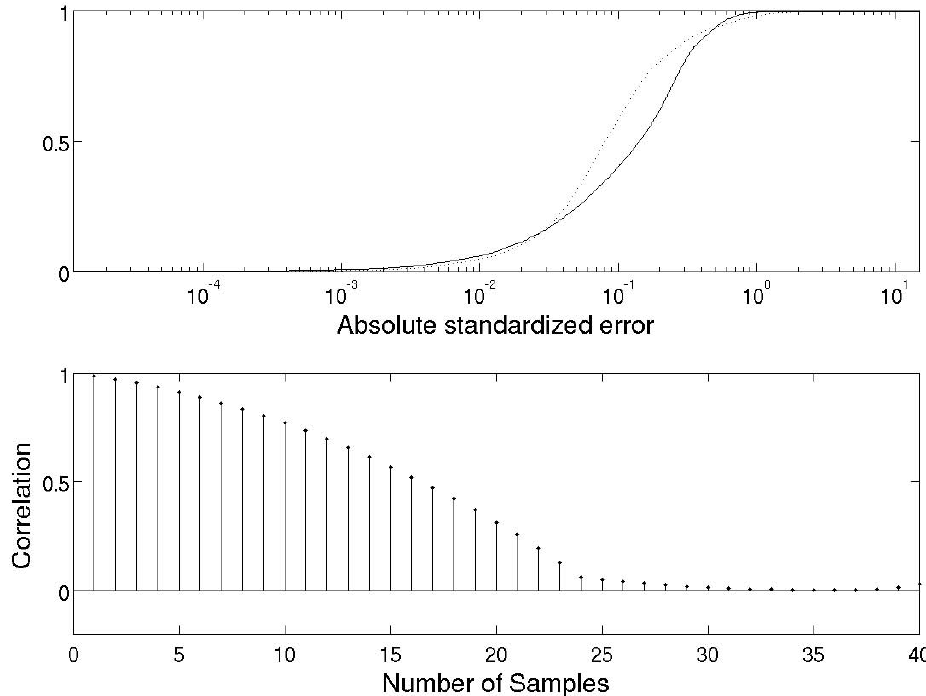
Fig. 4. Summary plots of the analysis of the 6h forecast residuals for the RW model calibrated using the SEFE methodology. The upper pane shows the cumulative distributions of the absolute values of the residuals at Welsh Bridge. The solid line being positive residuals and the dotted line being negative residuals. The lower pane shows the auto-correlation of the